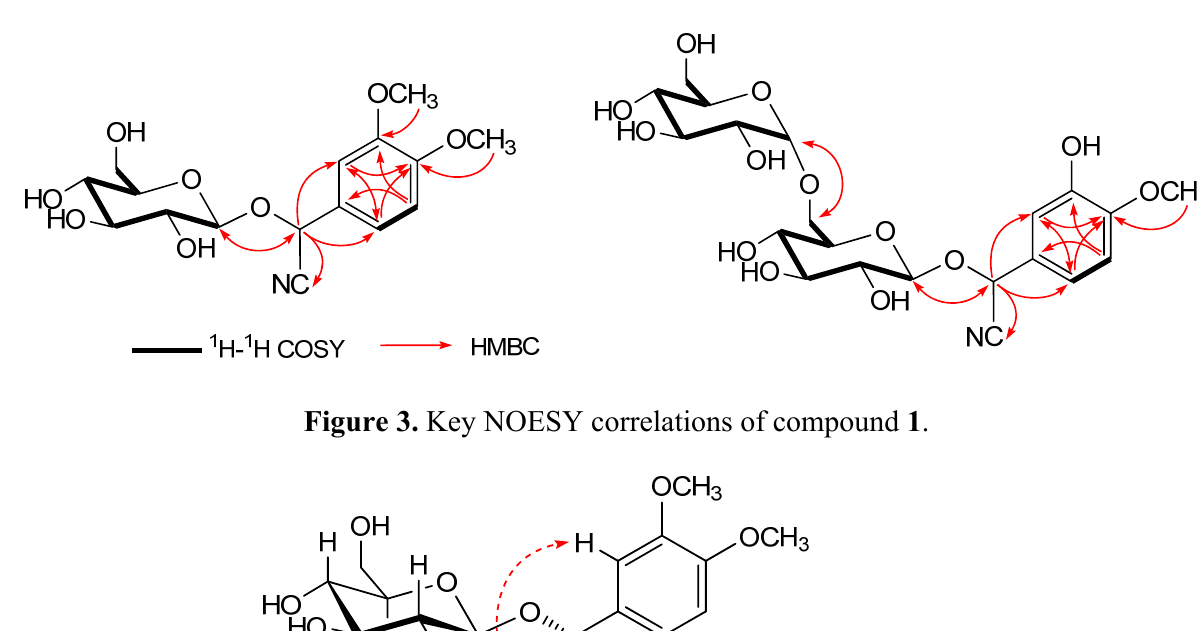
Figure 2. Key 1 H- 1 H COSY and HMBC correlations of compounds 1 and 2 .